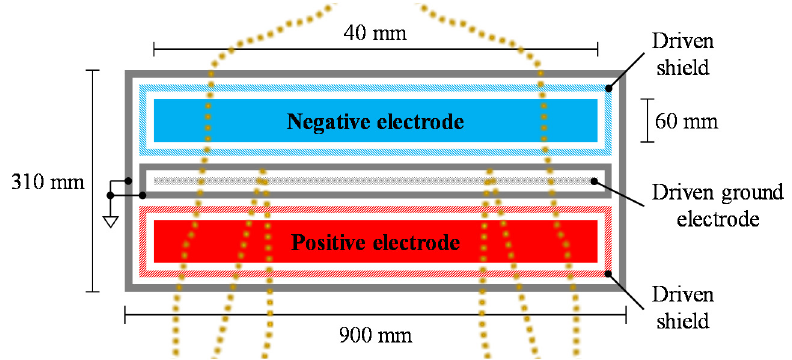
Figure3. Topviewconfigurationofflexiblesheetelectrode(FSE)forcECGmeasurement. Theconfiguration Figure 3. Top view configuration of flexible sheet electrode (FSE) for cECG measurement. The was modified from configuration was modified from [27,45].